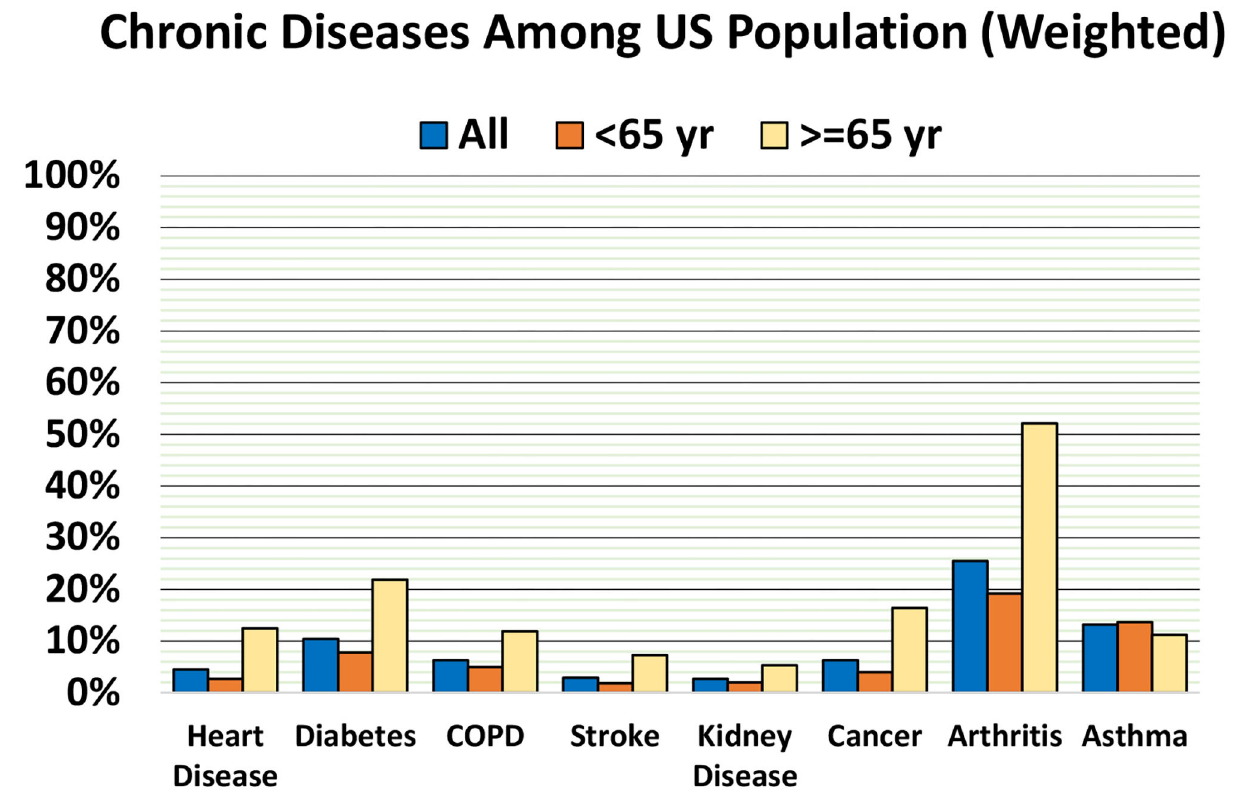
FIGURE 2 | Weighted prevalence of chronic diseases among US